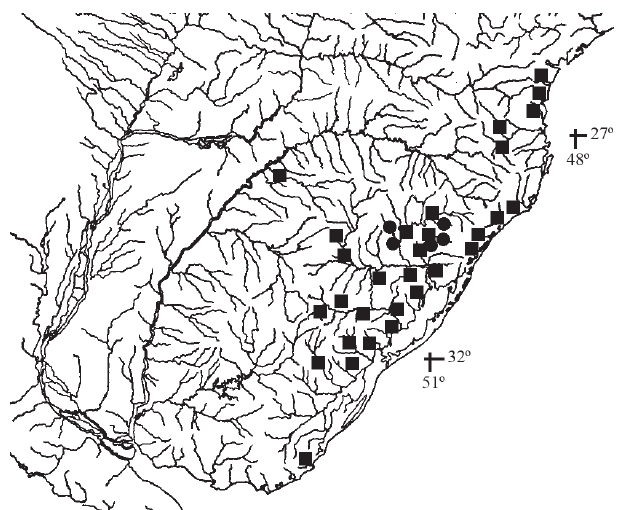
Fig. 5. Map of southern Brazil and Uruguay, showing the distribution of examined material of Astyanax obscurus (circles), and Astyanax laticeps (squares). Some symbols represent more than one lot or locality. Brazil: Rio Grande do Sul: laguna dos Patos system: rio Jacuí drainage: MCP 11145, 28, 31.3-83.3 mm SL, arroio Dizimeiro on the road between São Francisco de Paula and Lageado Grande.